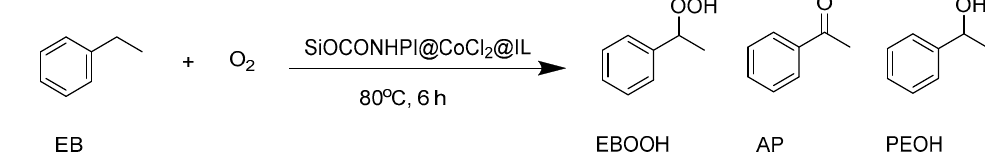
Figure 6. Ethylbenzene oxidation with oxygen in the presence of SiOCONHPI@CoCl 2 @IL.